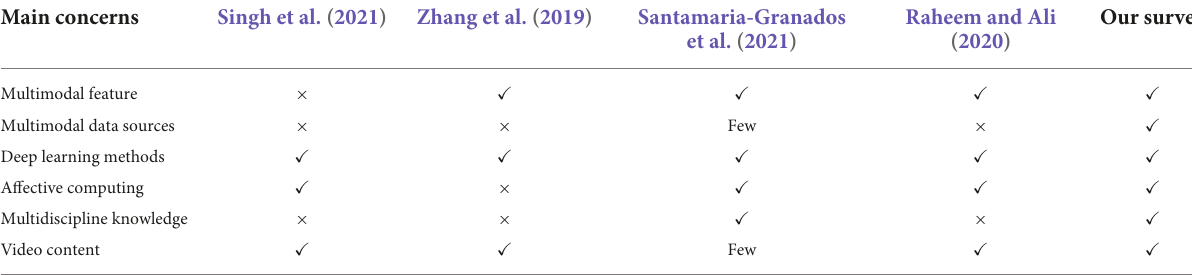
TABLE 1 Comparisons between this survey and existing